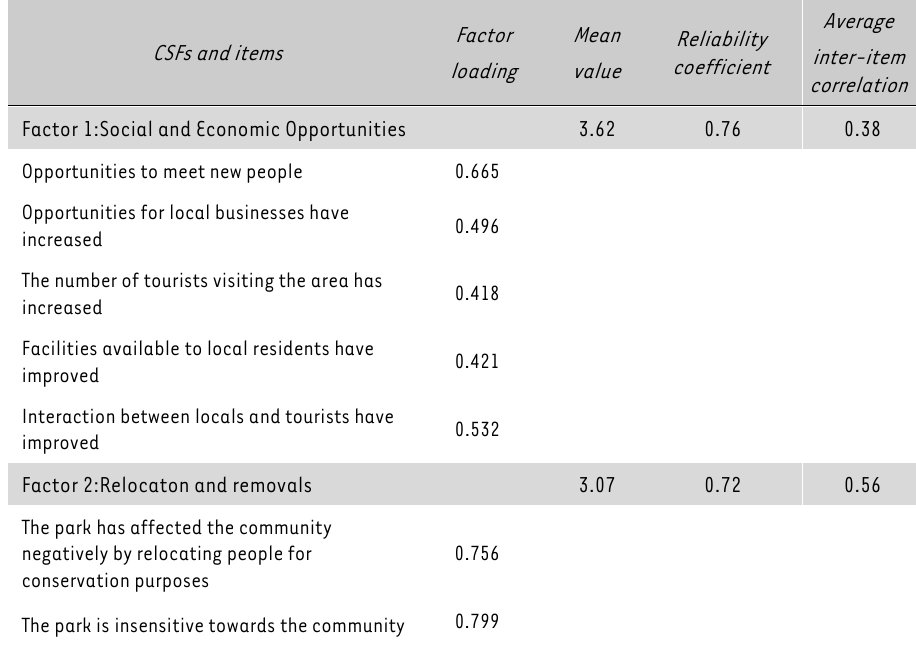
Results of the factor analysis on social statements CSFs and